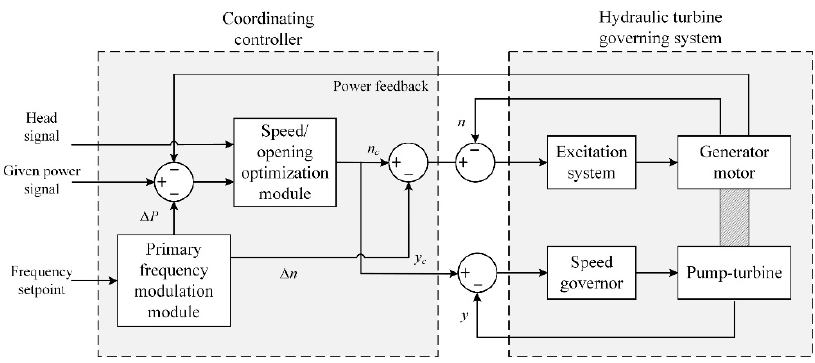
Figure 8. Schematic diagram of coordinated control of variable-speed unit.